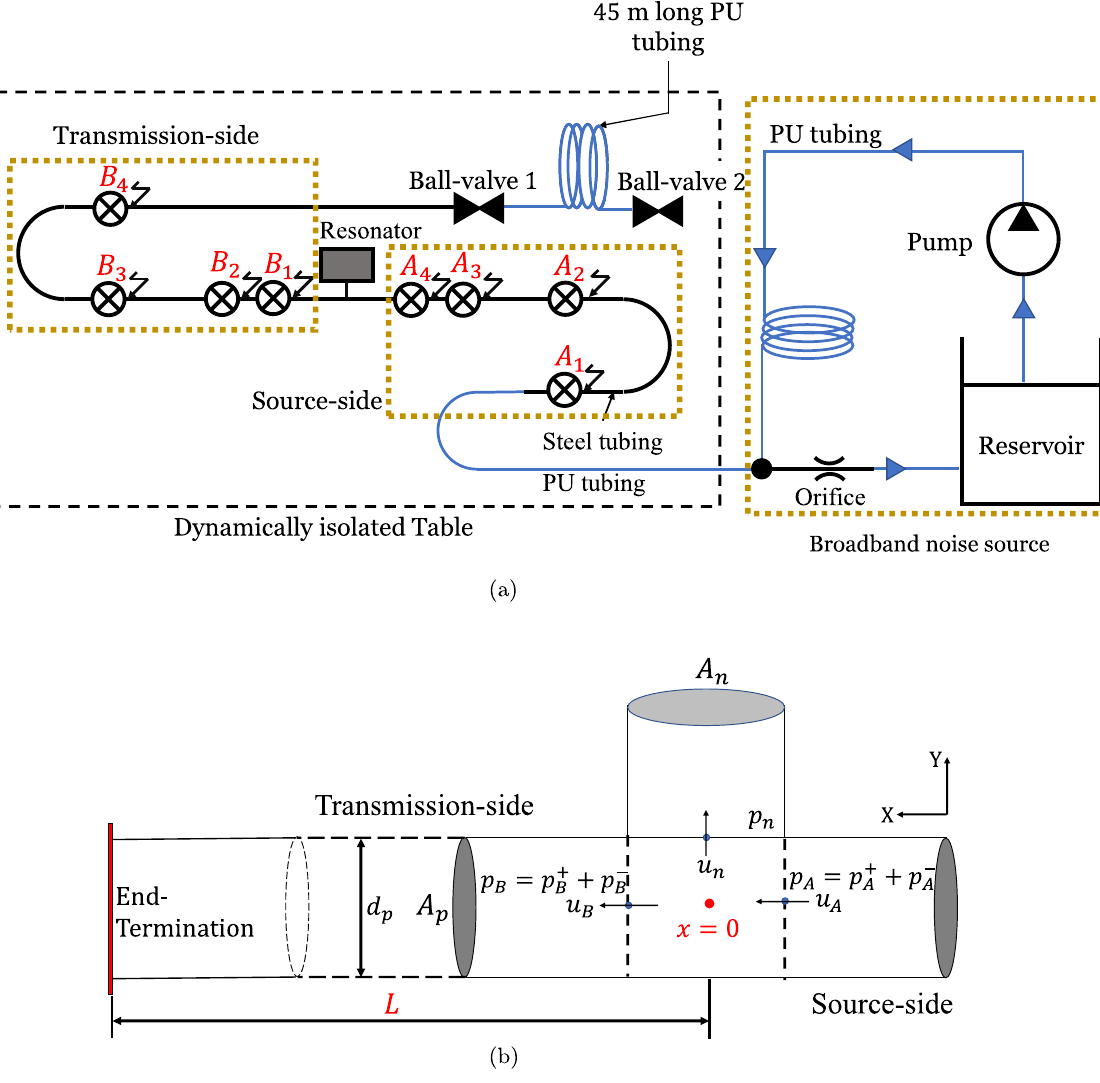
Figure 1. Schematic of the test-section and detailed view of the resonator neck. (a) Schematic of the experimental setup with source- side microphones ( A 1 , A 2 , A 3 , A 4 ) and transmission-side microphones ( B 1 , B 2 , B 3 , B 4 ). The entire fl ow system is the broadband noise source. There is no steady fl ow along the resonator in the main duct. (b) Schematic of the T-junction between the neck of the resonator and the main duct. The termination of the transmission side of the main pipe is either a closed end at the end of the steel tube (with closed ball-valve 1) or the PU tube termination (with closed ball-valve